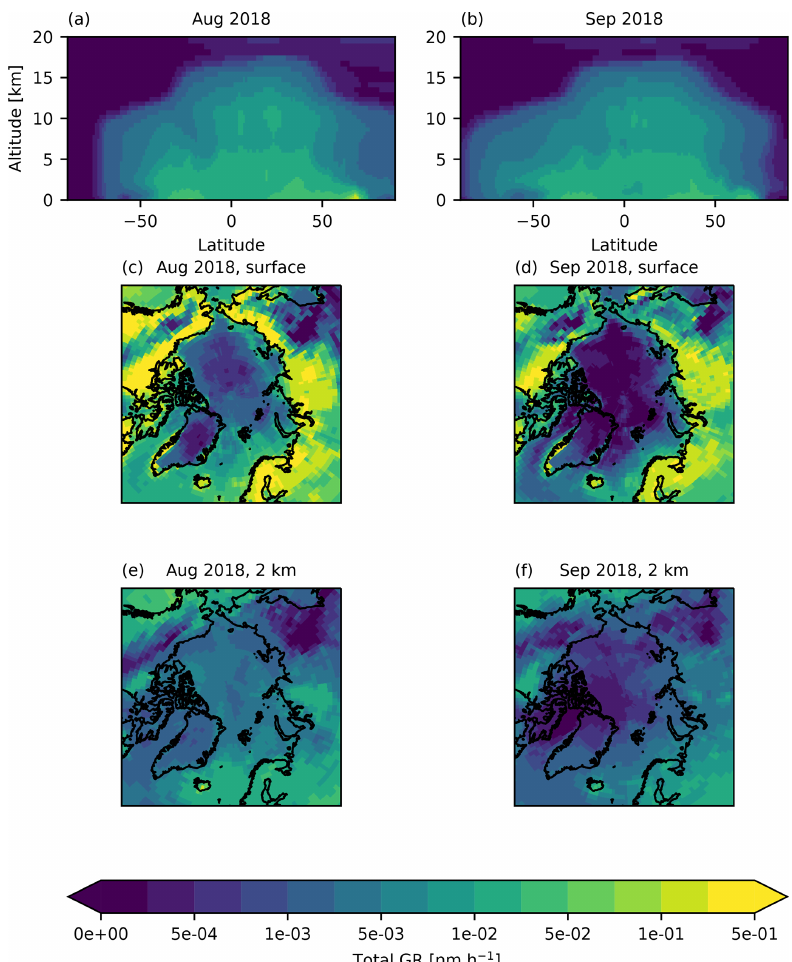
Figure E5. Zonal means and maps of aerosol growth rates from simulation CONTROL. Growth rates are calculated offline using model output of temperature and concentrations of H 2 SO 4 and secondary organic vapour. Maps are taken from model level (c–d) at surface and (e–f) with altitude